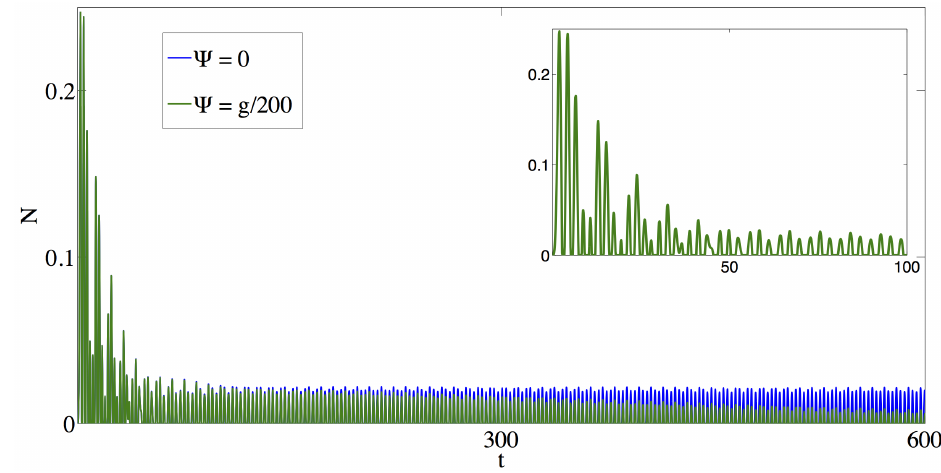
Figure 3. Time-evolution of the logarithmic negativity N , serving as a measure of entanglement, between the atomic ˆ b and ˆ c modes in the presence, Ψ (cid:54) = 0 (green), and absence, Ψ = 0 (blue), of the auxiliary ˆ w mode. Other parameters include δ = − 1 , ω = 1 , κ = 0 . 05 , γ = 0 . 05 κ and g/g = 1 . 05 . In the presence of the auxiliary ˆ w mode, R c the logarithmic negativity N monotonically decreases with time. The inset shows transient oscillations of N and N featuring multiple occurrences of entanglement sudden death Ψ=0 Ψ (cid:54) =0 and sudden birth. At these short times, the influence of the decay of the ˆ w mode is not apparent; we note that the characteristic time scale for this decay γ − 1 = 400 . Note that with γ = κ = 0 . 05 , we would still observe entanglement for t (cid:46) 50 and, thereby, also several deaths/births of the